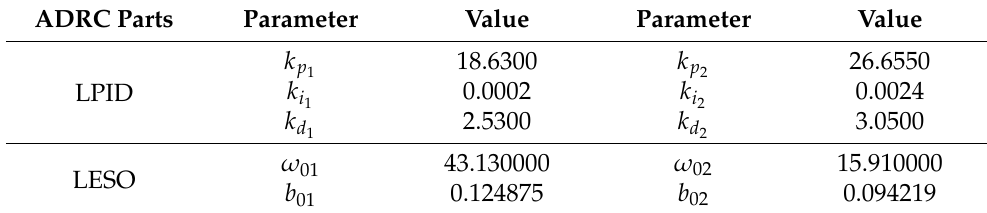
Table 6. LADRC parameters.